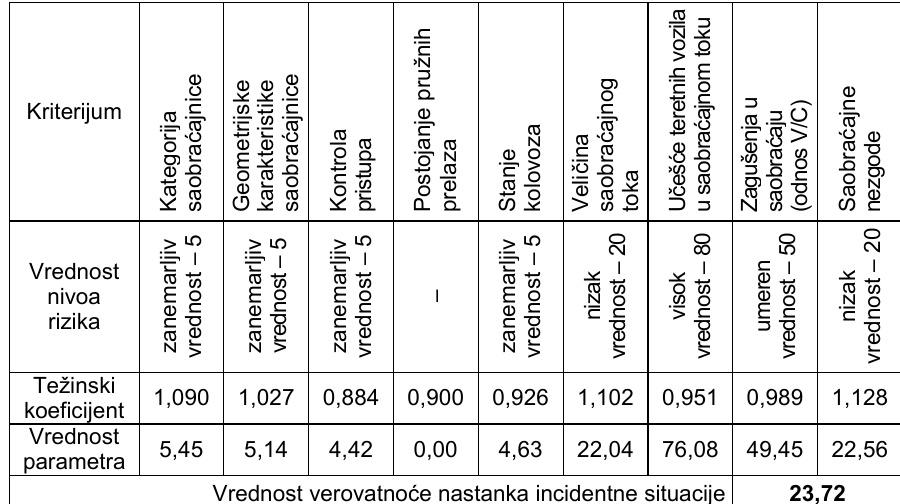
Table 3 – The values of the parameters affecting the probability of occurrence of incidents for the section through Stepojevac